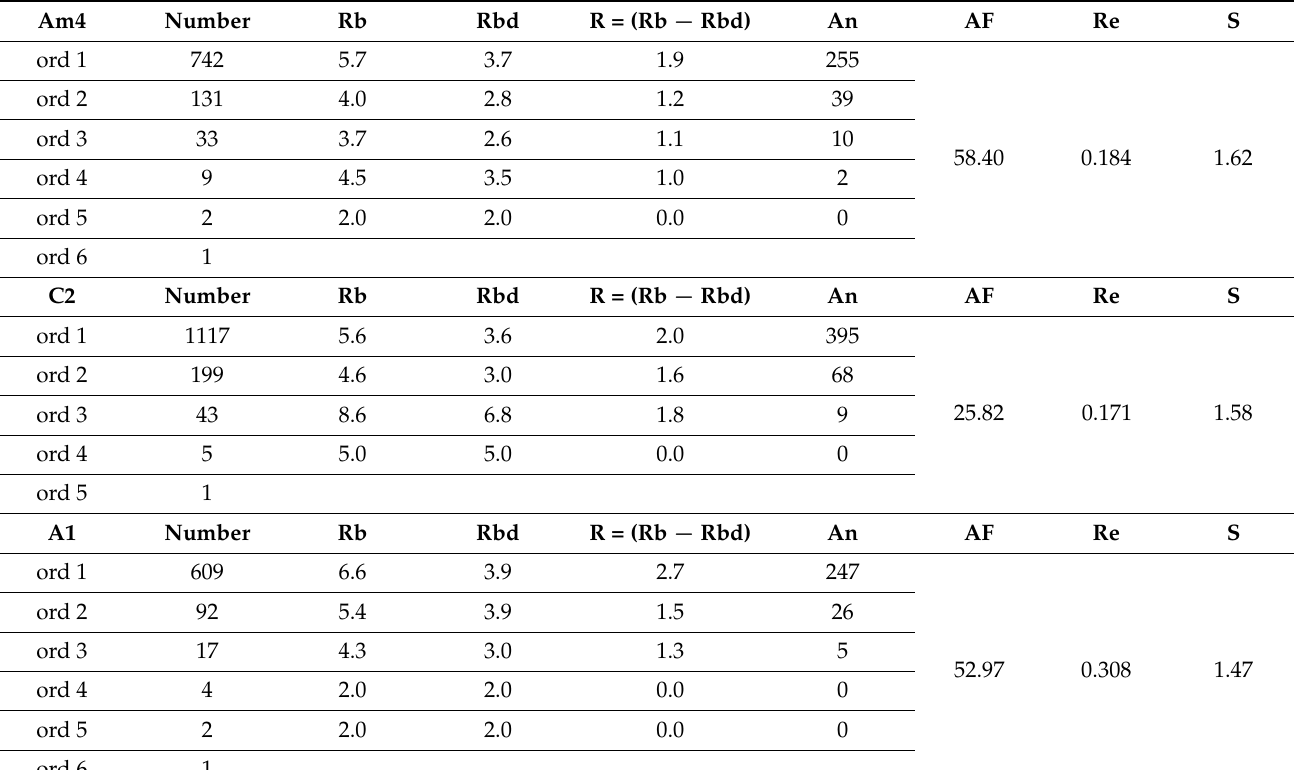
Table 2. Hierarchical parameters and geomorphic indexes of the three major river drainage